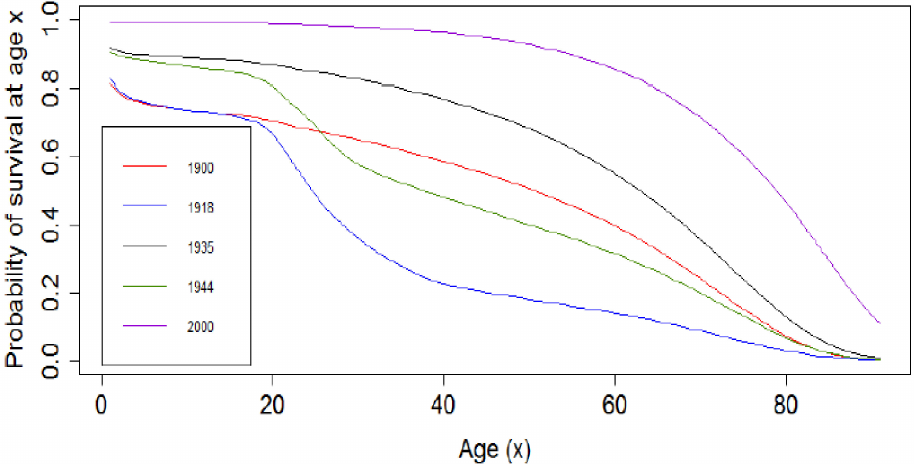
Figure 2. Mortality rates (log) of French males from